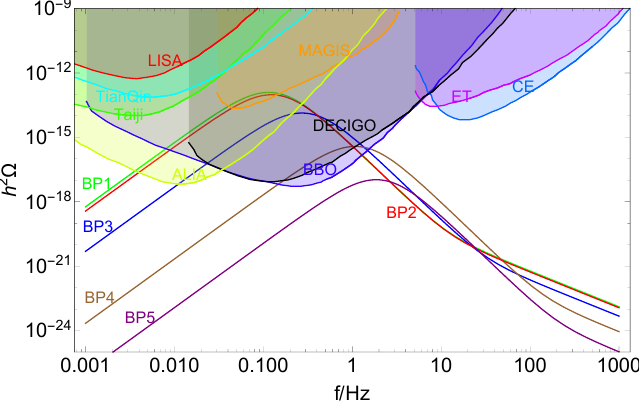
Figure 7 . Combined plot of the experimental limits in figure 1 (blue and pink blocks with arrows) and the GW prospects of the masses of H 0 (green hatched regions). The horizontal black lines are the masses of SM Higgs h , top quark t , and W , Z bosons.